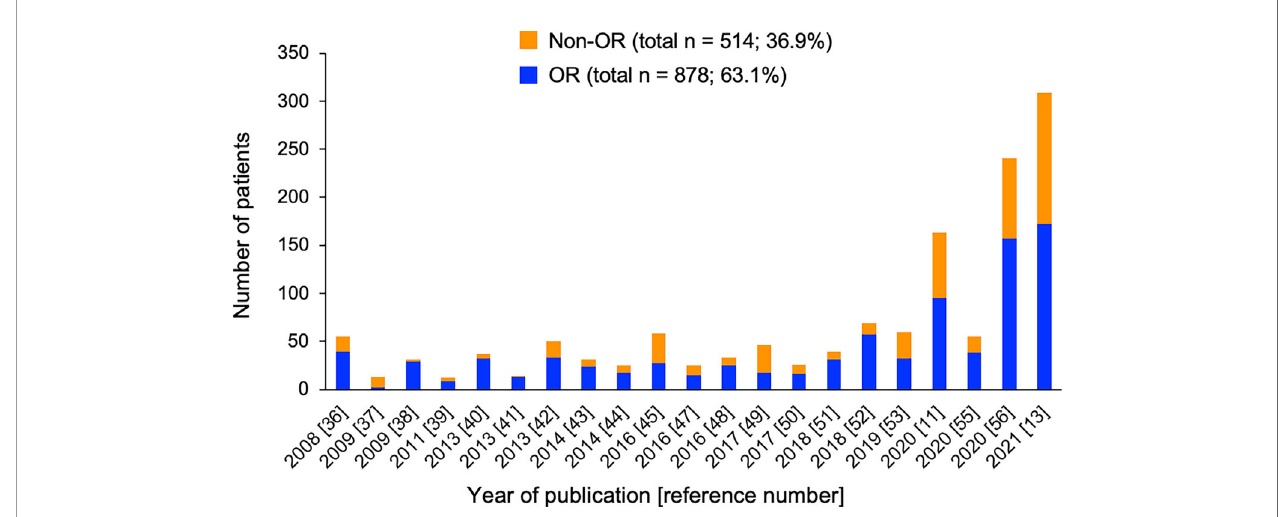
FIGURE 1 | Number of patients with (blue) and without (orange) overall response (OR) in each study of MSC therapy for acute GVHD. Total numbers and percentages of patients with or without OR as the sum of all reported cases are